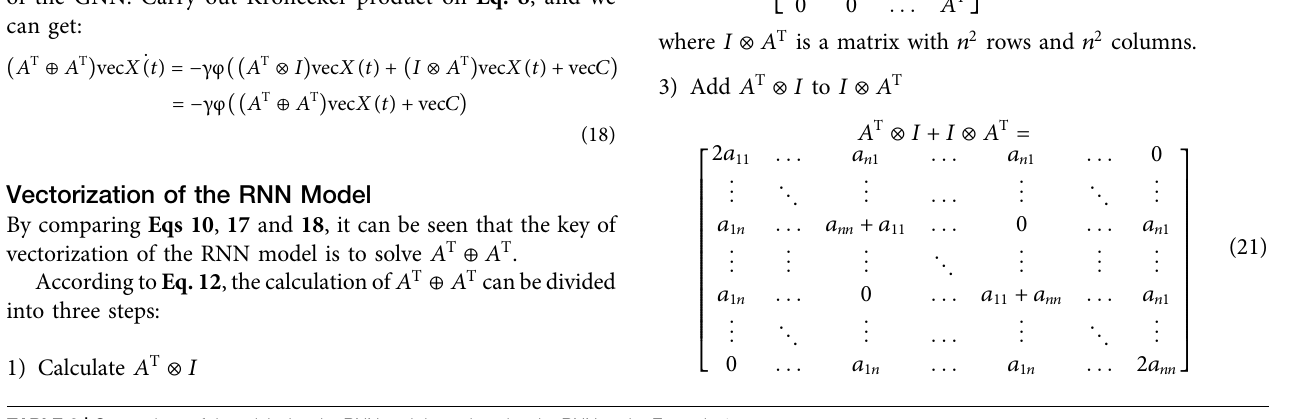
TABLE 2 | Comparison of the original-order RNN and the reduced-order RNN under Example